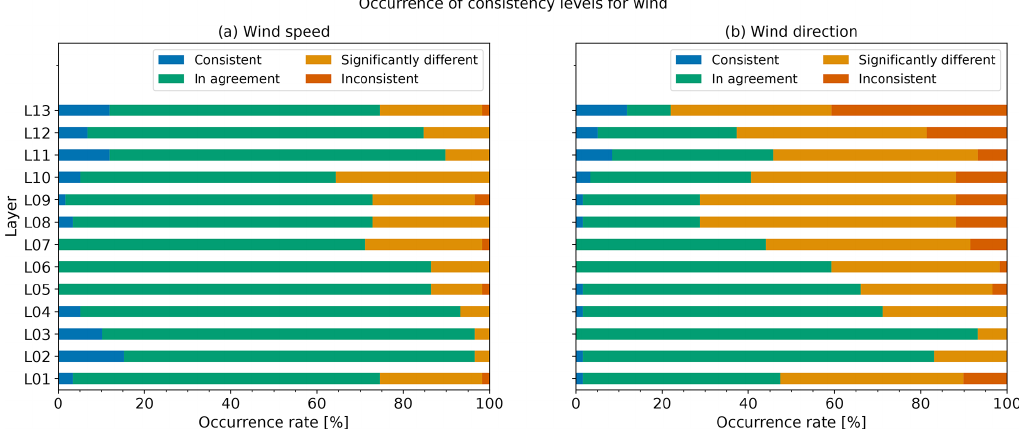
Figure 30. Wind consistency rank for individual pressure layers. (a) Wind speed. (b) Wind